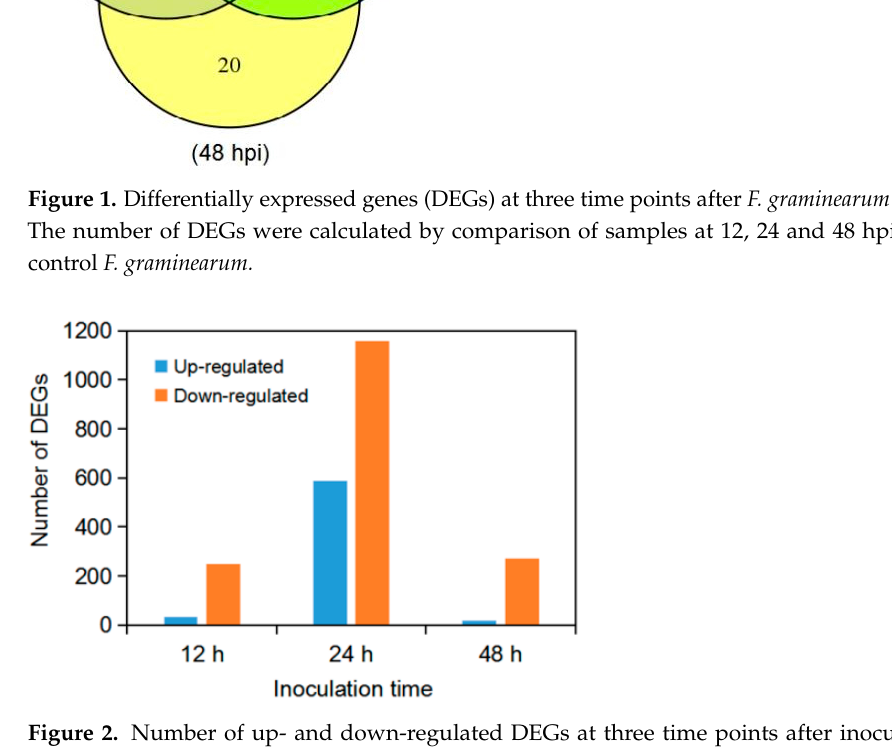
Figure 2. Number of up- and down-regulated DEGs at three time points after inoculation with F. graminearum .